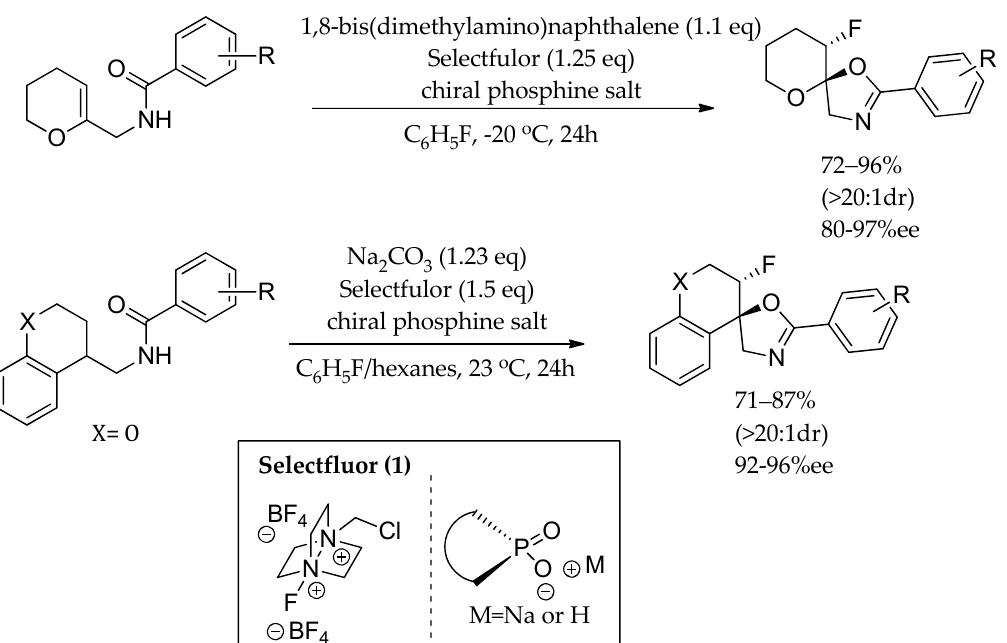
Scheme 6. Enantioselective tandem fluorocyclization PTC protocol.